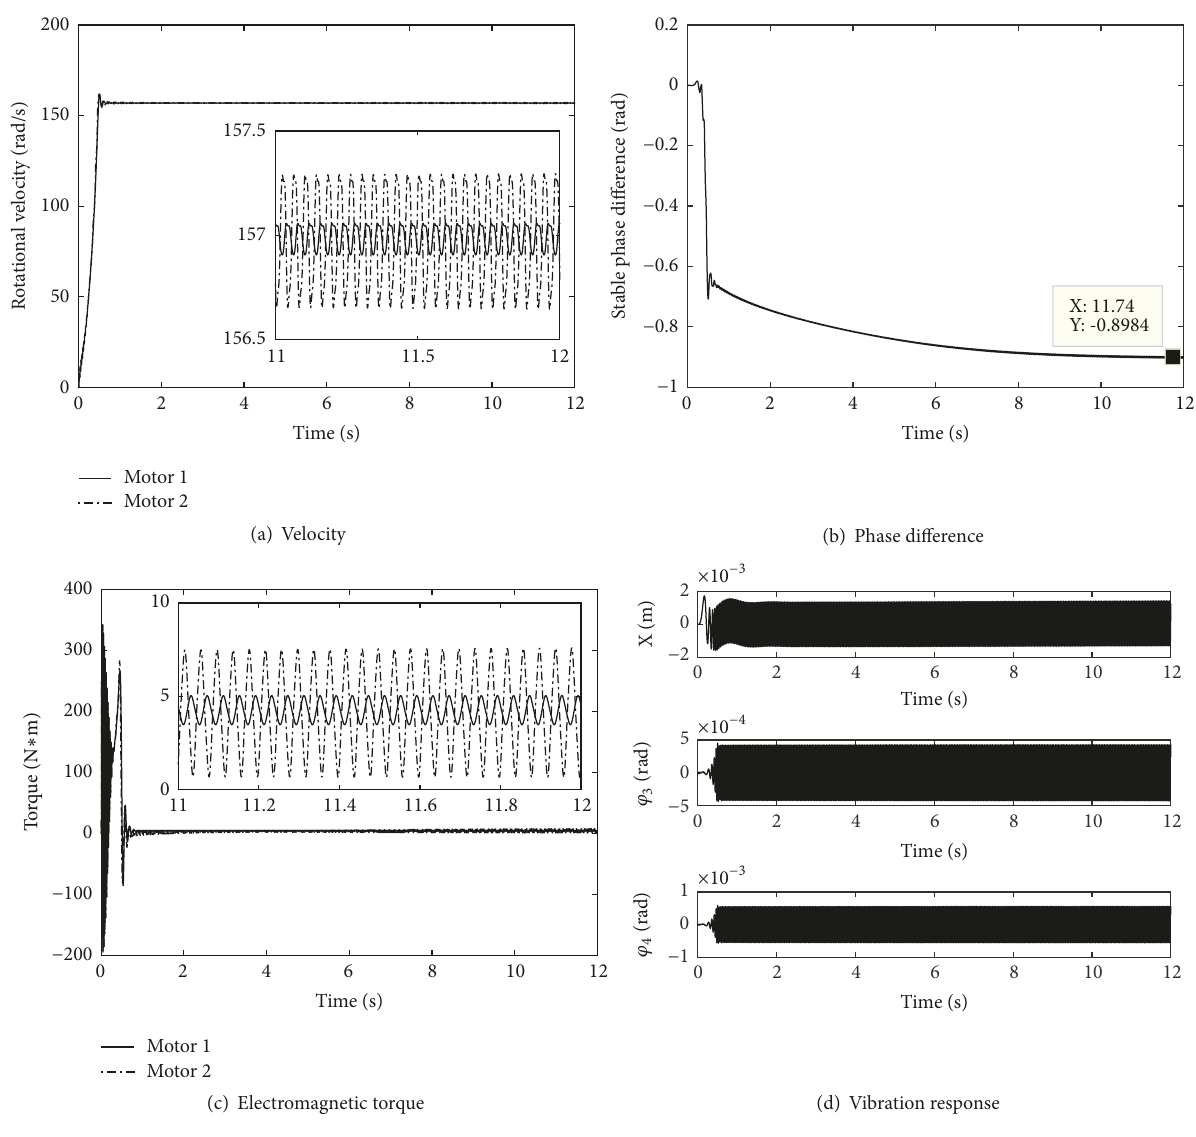
Figure 5: The dynamic characteristics when the rotors rotate in the same